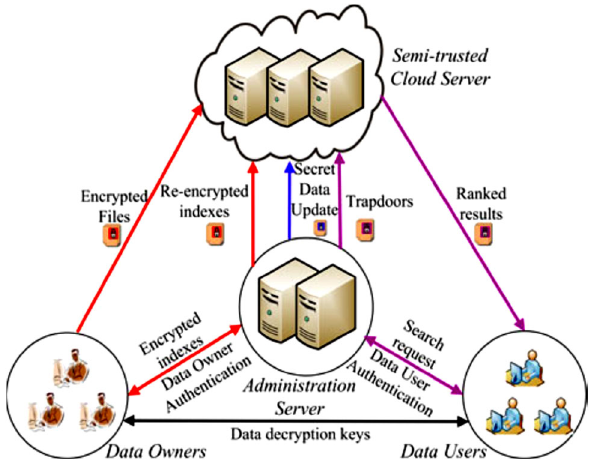
Fig. 5 Architecture of privacy-preserving keyword search in a multi- owner and multi-user